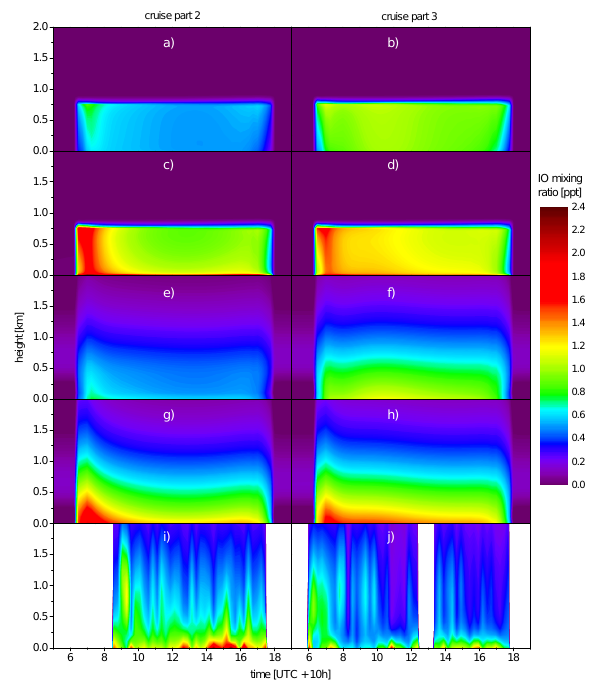
Fig. 9: IO simulations of the MISTRA model (a - h) and inferred IO profiles from the Fig. 9. IO simulations of the MISTRA model (a–h) and inferred MAX-DOAS measurements (i, j) for a typical scenario of cruise part 2 (left column) IO profiles from the MAX-DOAS measurements (i, j) for a typi- and cruise part 3 (right column). Panel a) and b) excluding an additional inorganic io- cal scenario of cruise part 2 (left column) and cruise part 3 (right dine flux, Panel c) and d) including an additional inorganic iodine flux of I 2 = 1.8 · 10 8 column). Panels (a) and (b) excluding an additional inorganic io- molec / (cm 2 · s) and I 2 = 1.0 · 10 8 molec / (cm 2 · s) , respectively, Panel e) - h) same as a) - dine flux, (c) and (d) including an additional I 2 flux of j part 2 = d) but artificially degraded, Panel i) and j) retrieved from the MAX-DOAS measurements 1 . 8 × 10 8 moleccm − 2 s − 1 and j part 3 = 1 . 0 × 10 8 moleccm − 2 s − 1 , for October 14, 2009 and for October 23, 2009, respectively. The colour coding represents respectively, (e) – (h) same as (a) – (d) , but artificially degraded, (i) IO mixing ratios in units of ppt . and (j) retrieved from the MAX-DOAS measurements for 14 Octo- ber 2009 and for 23 October 2009, respectively. The colour coding represents IO mixing ratios in units of